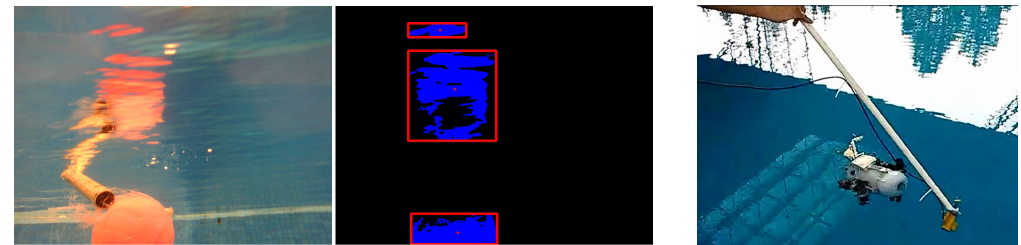
Figure 7. Segmentation to different blobs and the detection of another